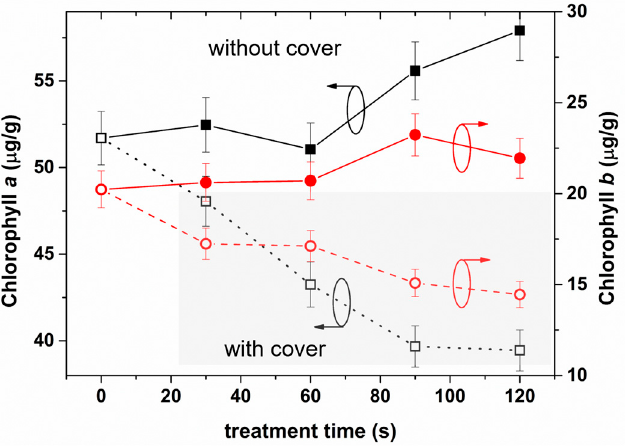
Figure 8. Concentrations of Chlorophyll a and Chlorophyll b in cress sprouts for seeds treated without cover (full squares—Ch a , full circles—Ch b ) and with cover (empty squares—Ch a , empty circles—Ch b ).